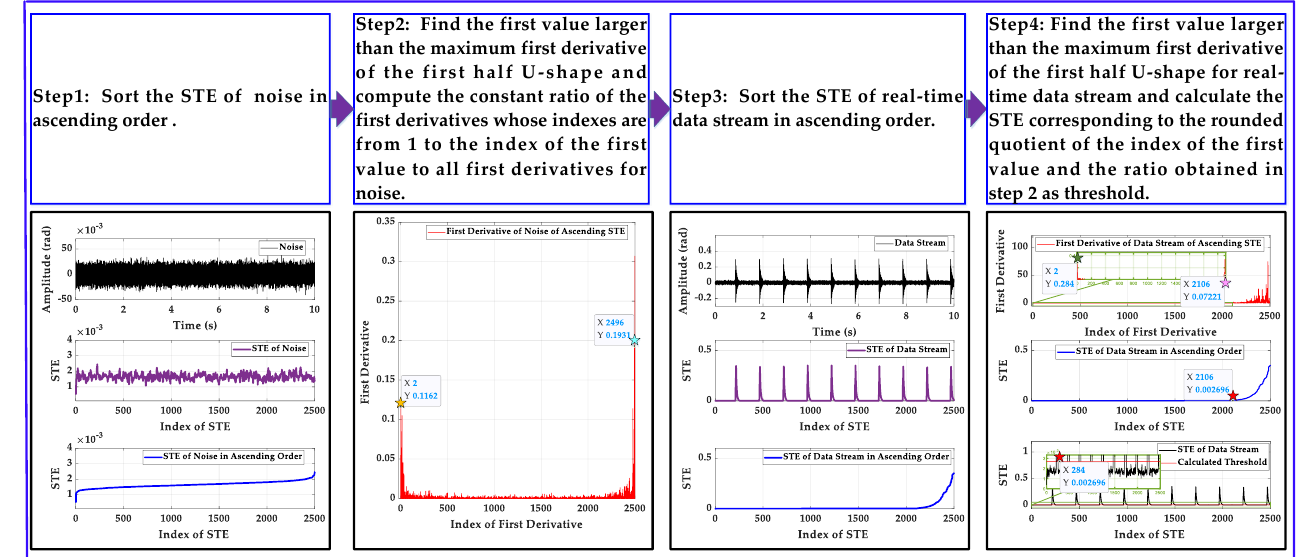
Figure 1. The flow chart of signal activity detection with the adaptive-calculated threshold and the calculation results of every step.